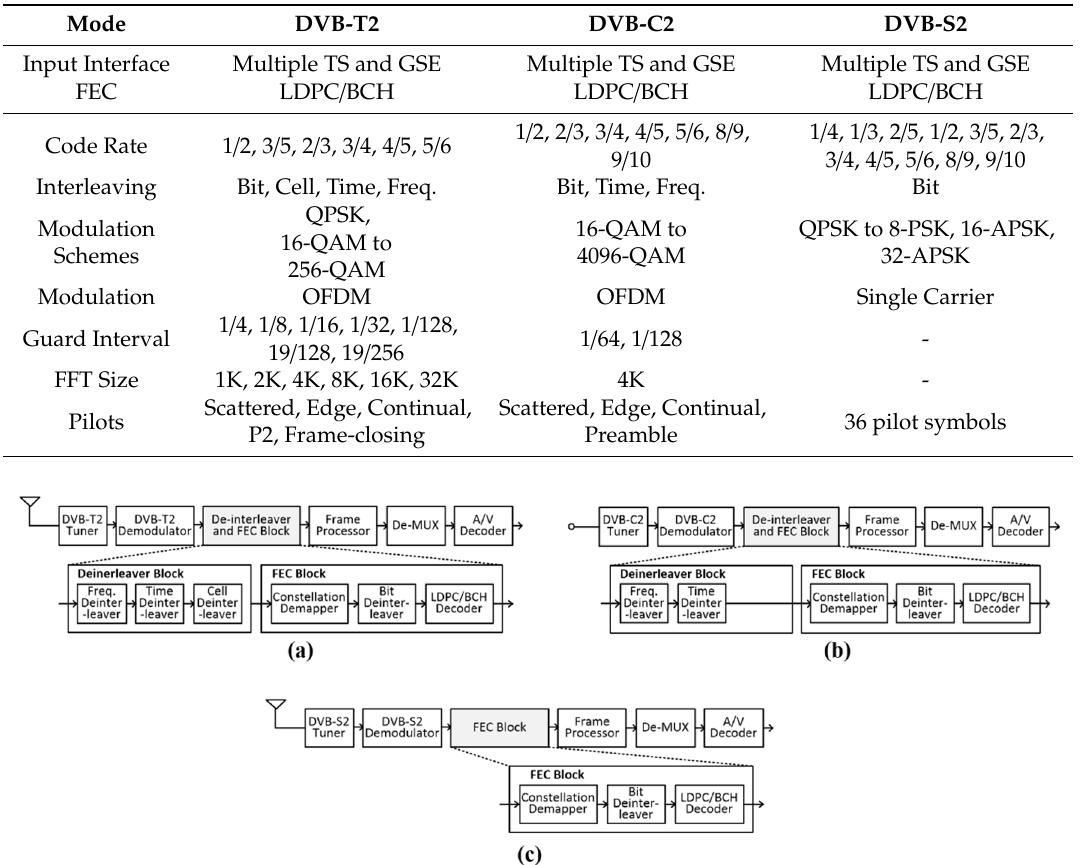
Table 1. DVB-T2, DVB-C2, and DVB-S2 features.